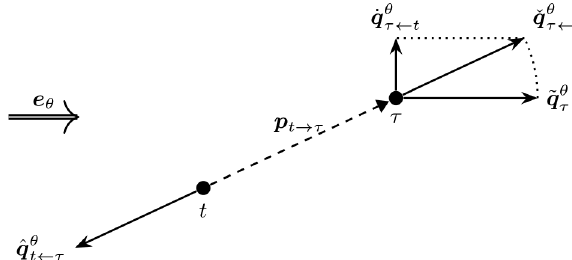
Figure 1. Illustration of the four pseudo-gradient vectors for the single wind case and single wake interaction